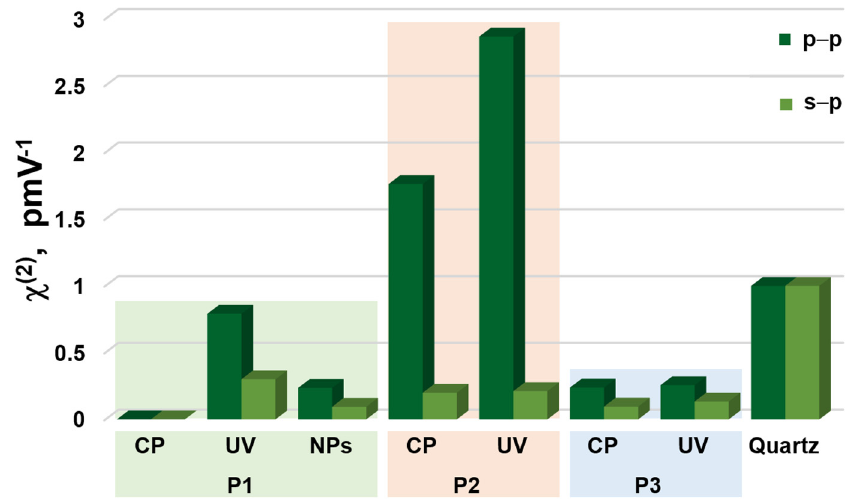
Figure 8. Histogram representing values of χ (2) in s–p and p–p laser beam of polymer P1, P2, and P3 after corona poling (CP), UV–irradiation (UV), with ZnO nanoparticles (NPs), and comparison with reference material Y–cut quartz.